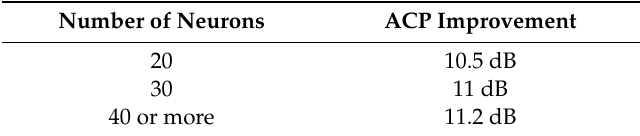
Table 4. ACP improvement when varying the number of neurons of the neural network in the selected LDMOS amplifier.